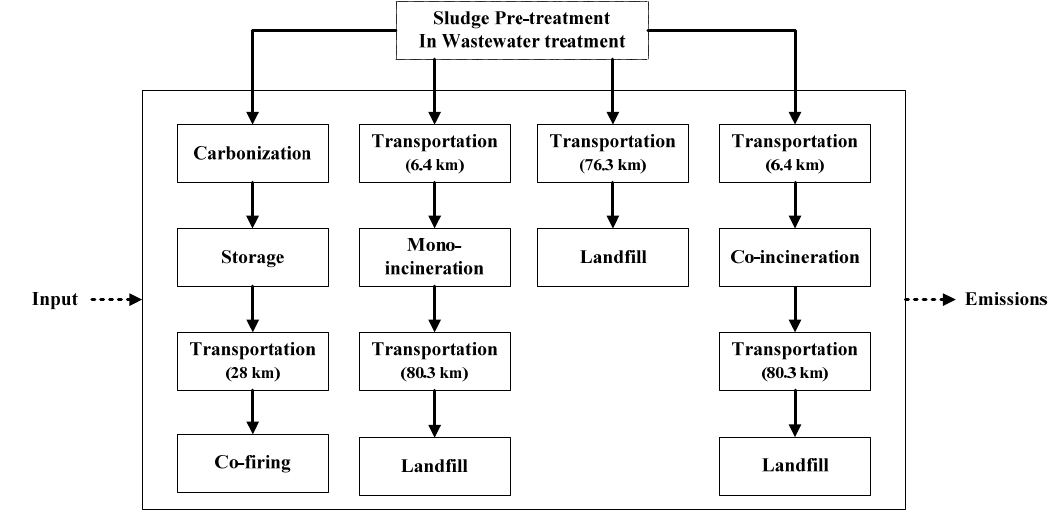
Figure 2. System boundary. Values in parentheses are transportation